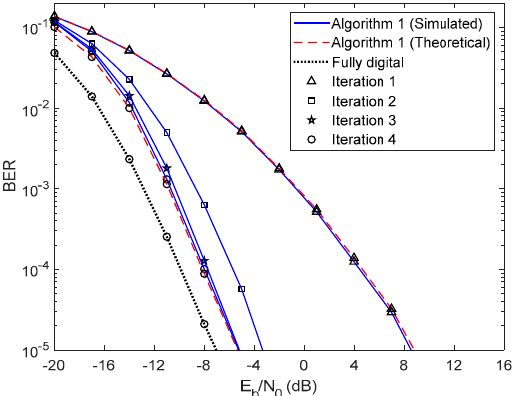
Figure 4. Performance of the proposed hybrid iterative multi-user equalizer (Algorithm 1) for the PCSI precoder with ULA configuration and QPSK modulation.